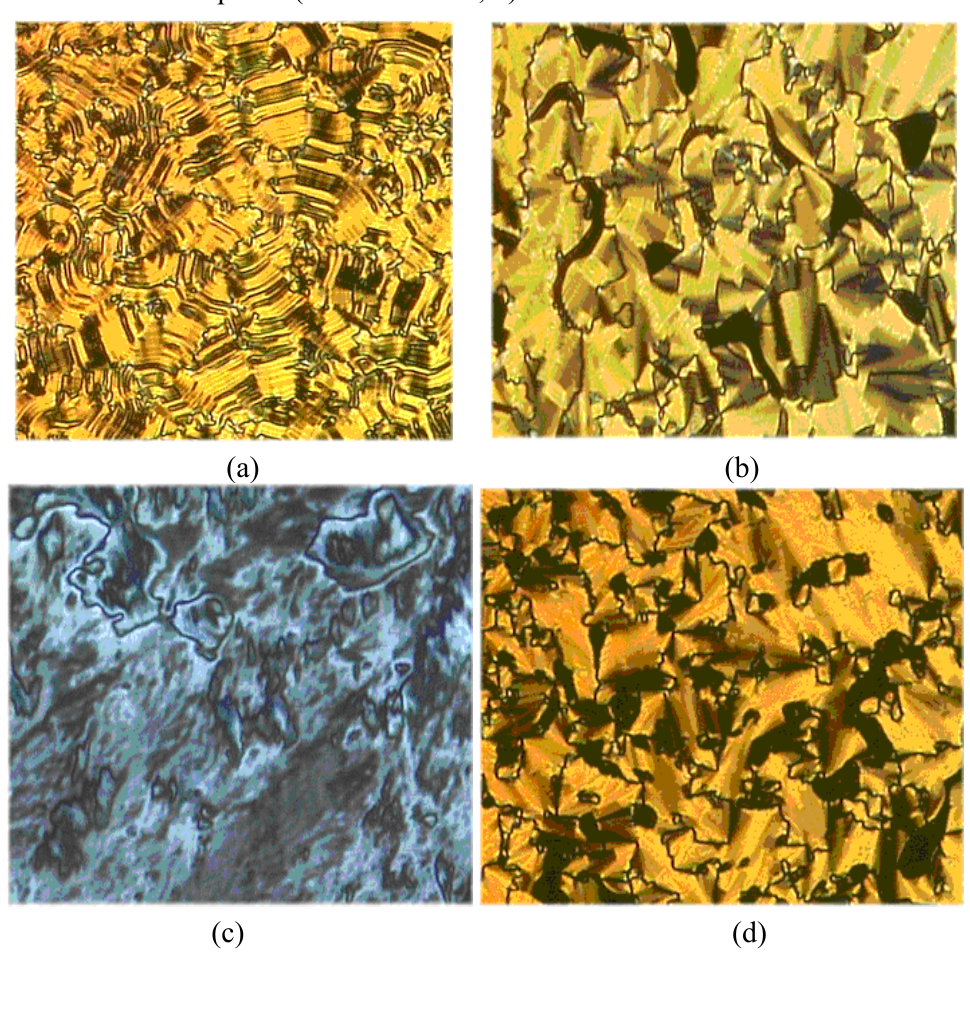
Figure 8. Photomicrographs of the optical textures of mesophases obtained for the unsymmetrical azomethine AP1A . The banded focal-conic fan texture of the smectic G (or J) phase (seen at 120 ° C, a), the broken focal-conic texture of the SmF (or I) phase (seen at 135 ° C, b), the schlieren texture of the SmC phase (seen at 157 ° C, c) and the focal-conic fan texture of the SmA phase (seen at 170 ° C,